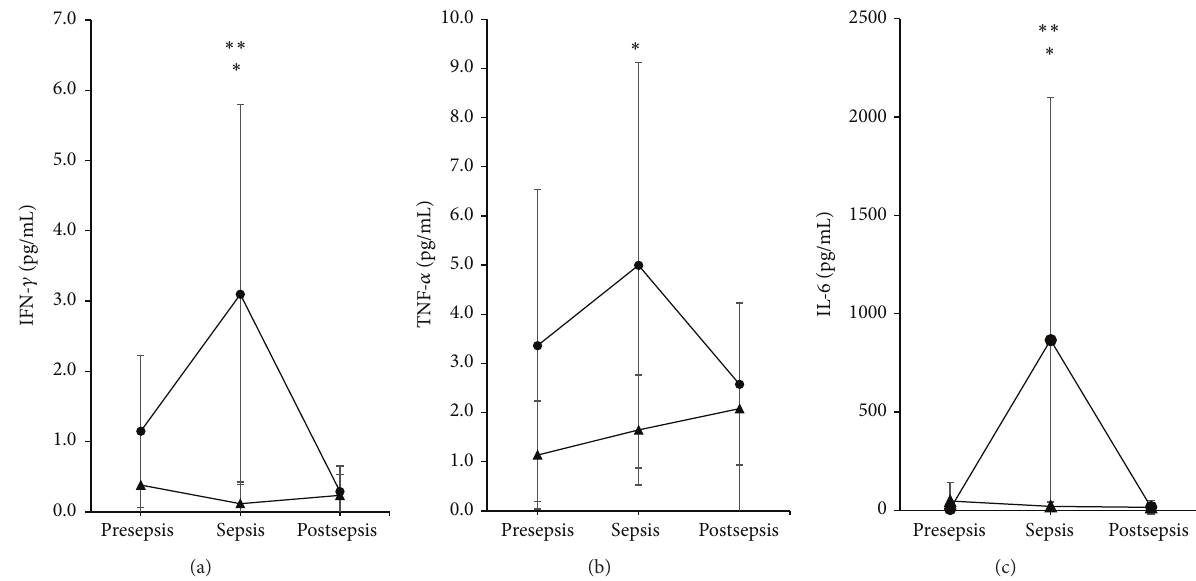
Figure 3: Proinflammatory cytokines. IFN- 𝛾 (a), TNF- 𝛼 (b), and IL-6 (c) showed similar patterns during the sepsis process (mean ± standard deviation). During sepsis, the values for the PT infants (circle) were elevated compared with VPT (triangle) infants ( ∗ 𝑃 < 0.01 , Student’s 𝑡 - test). Values at sepsis were higher than pre- and postsepsis in the case of IFN- 𝛾 and IL-6 for PT group ( ∗∗ 𝑃 < 0.01 , Friedman test).